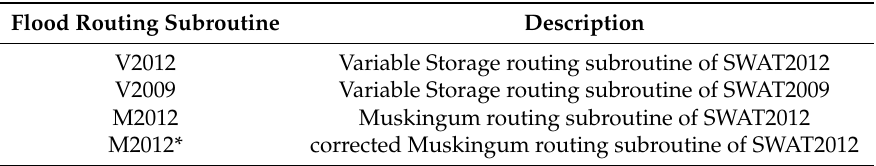
Table 1. List of the hydrologic routing subroutines used for this study.